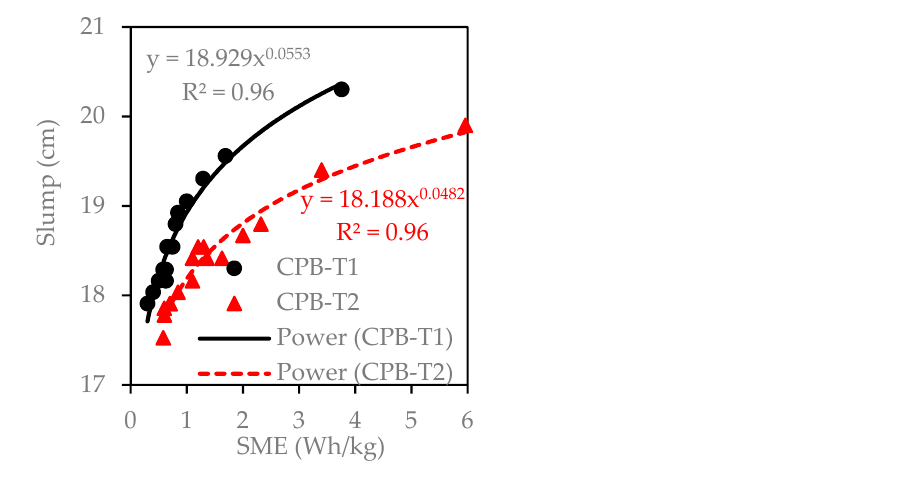
Figure 10. Effect of SME on the slump of CPB mixtures prepared with tailings T1 and T2. In general, slump increases with increasing SME dissipation during mixing. Slump tends to increase significantly for SME below about 2 Wh/kg. Thereafter, the slump increase rate tends to slow slightly with increasing SME. This indicates improved mixture consistency with increasing SME, concurring with results obtained by [33] on cement